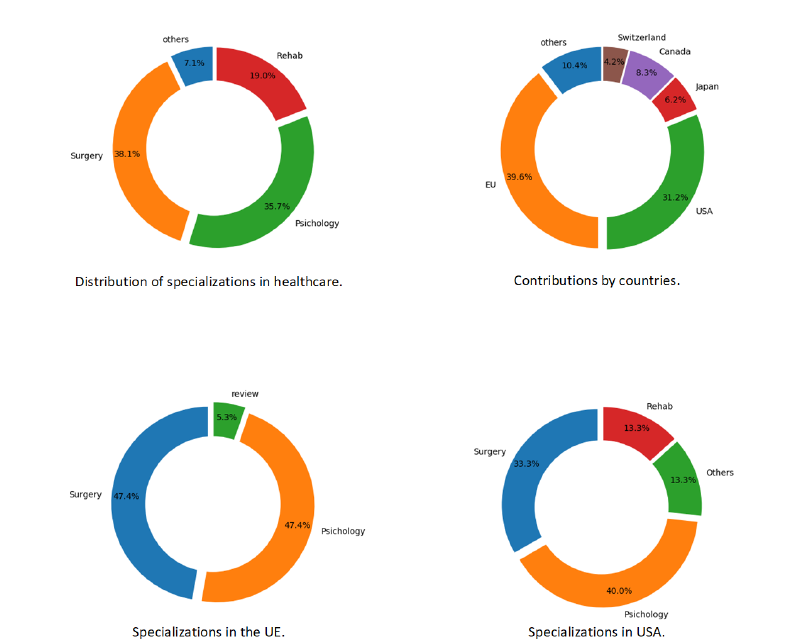
Figure 11. Information about publications on healthcare: in the top left image is the percentage of publications made on healthcare. In the top right is the percentage of publications made by countries. In the bottom left is the publications made in the EU, and in the right bottom is the information of publications made in